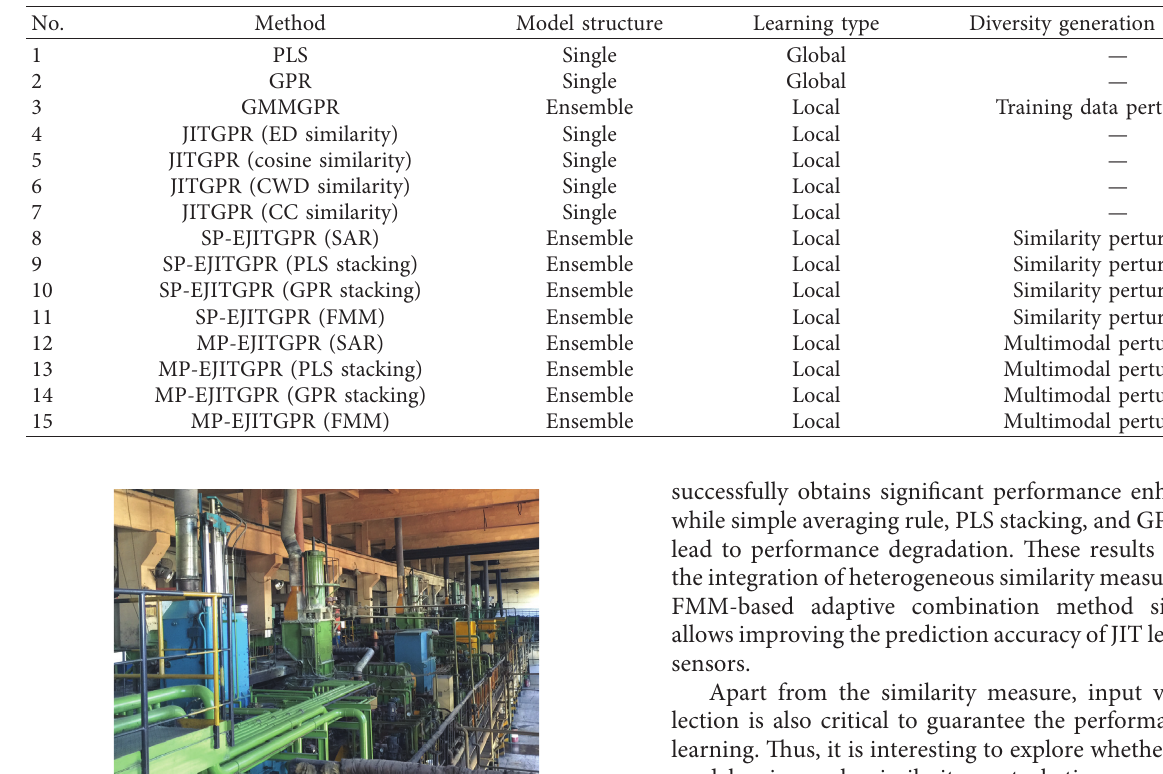
Table 1: Characteristics of soft sensor methods for comparison.